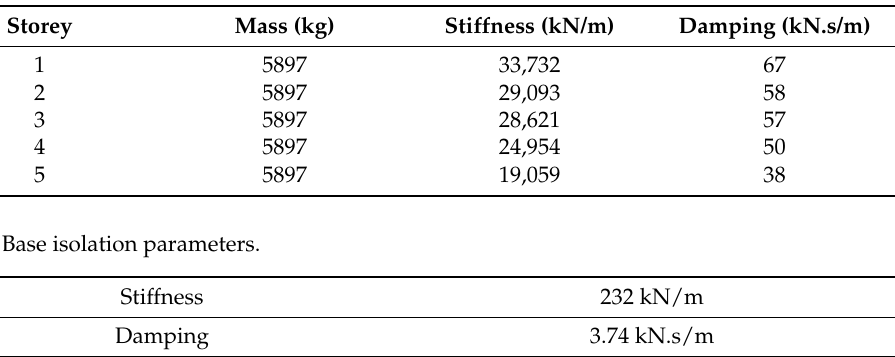
Table 1. Structure parameters.